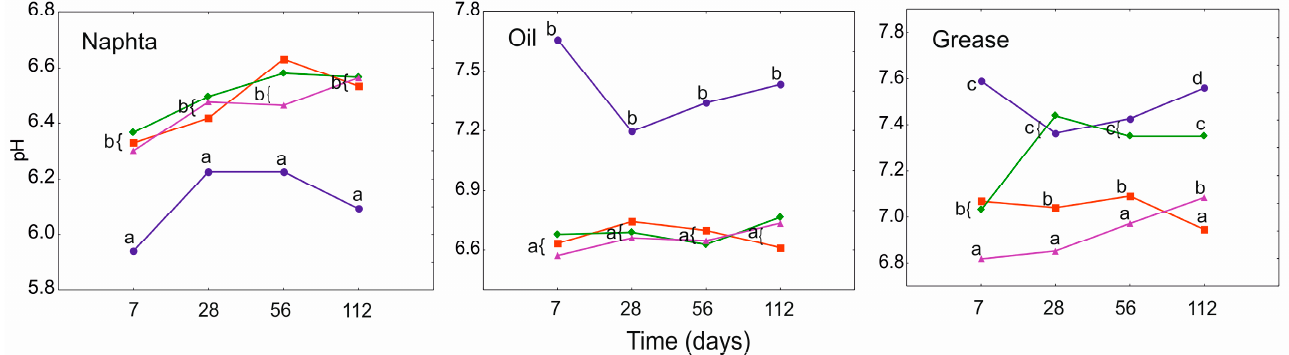
Figure 3. GLMM for mean pH (calculated from concentration of H + ions) of heavy naphtha, lubrica- tion oil, and grease for PGA treatment (blue and circle—PGA 0 , red and square—PGA 1 , green and diamond—PGA 1B , violet and triangle—PGA 10 ) and time (days). The different letters indicate the pairwise differences according to Duncan pairwise test. Mean values, standard error, and confidence intervals are included in Supplementary Material Table